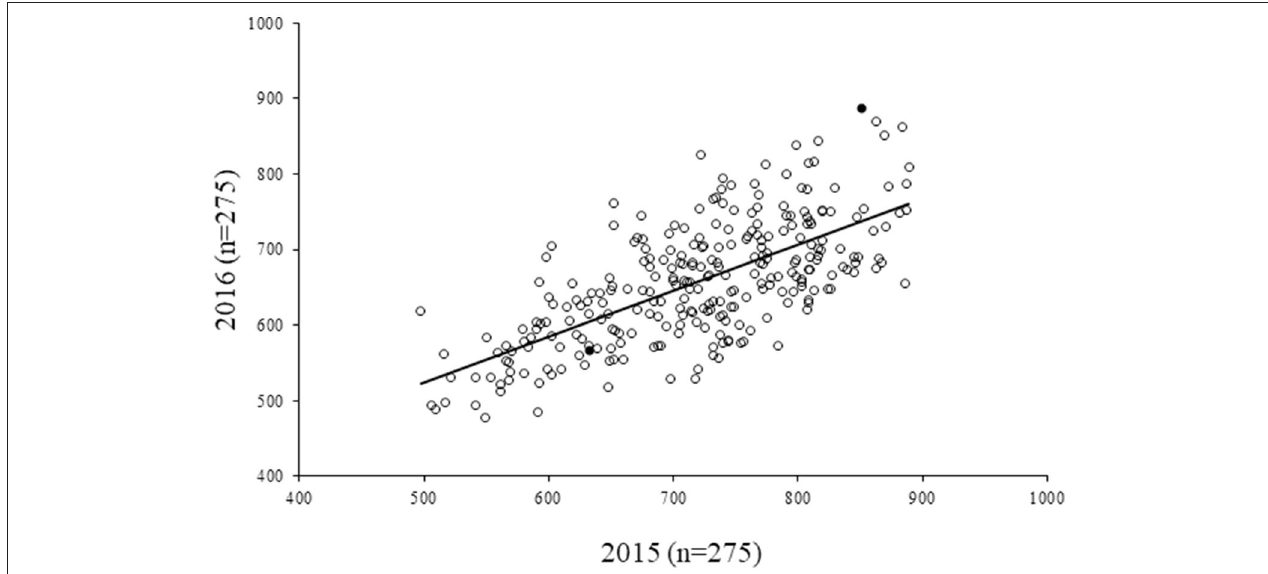
FIGURE 1 | Correlation of GPA content in 275 finger millet accessions between two seasons (2015 and 2016). r 2 = 0.472; r = 0.688, p < 0.001. Filled circles represent the accessions that were eventually selected for human iron absorption studies.